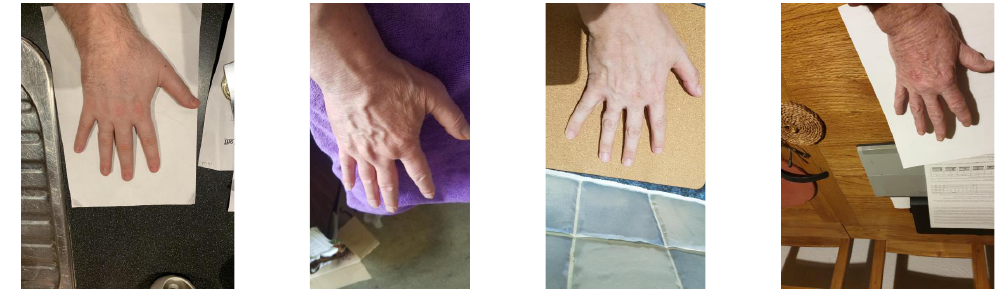
Figure 2. Sample images from the HUQ